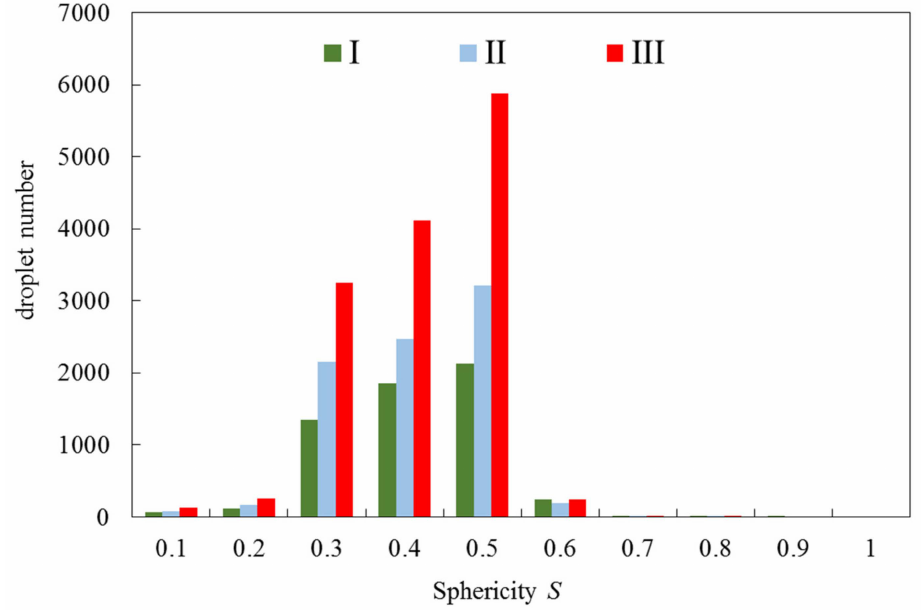
Figure 13. Sphericity of droplets. I: p injection = 80 MPa, p b = 1 MPa; II: p injection = 100 MPa, p b = 1 MPa; III: p injection = 120 MPa, p b = 1